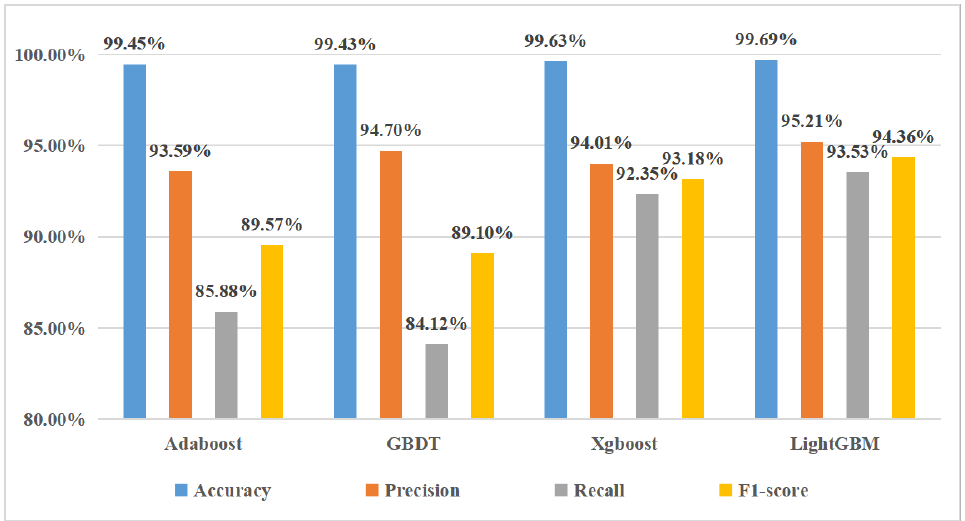
Figure 5. Comparison of the experimental results. The evaluation indicators of the four models are shown in the figure. The four color histograms, which represent four evaluation indicators, are Accuracy, Precise, Recall, and the F1-score, from left to